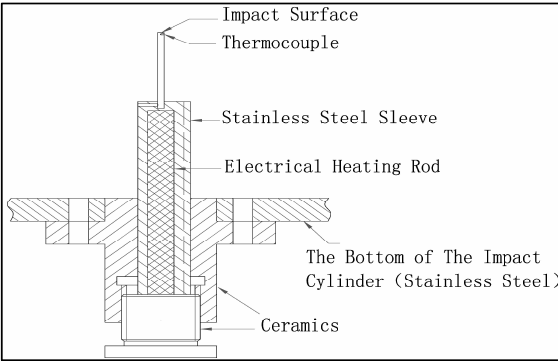
Figure 2. Schematic of the temperature control principle of the impaction